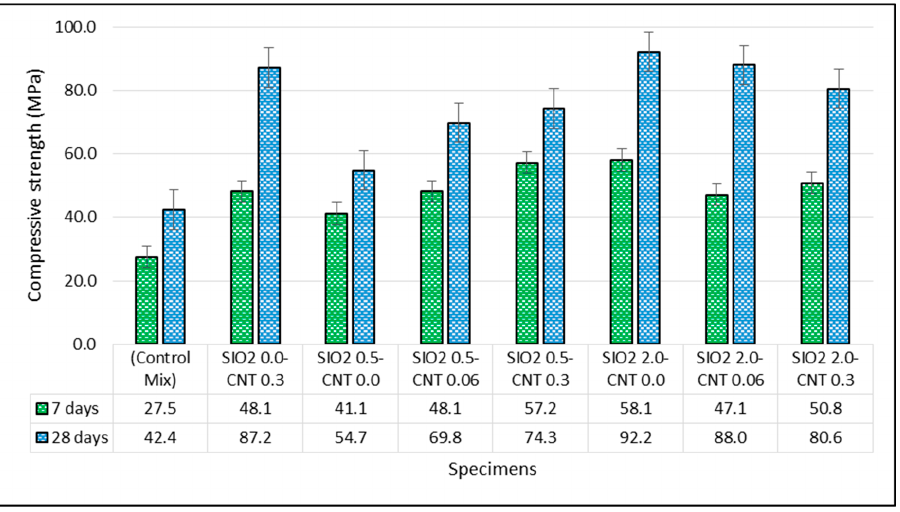
Figure 3. Compressive strength of cement paste specimens at the ages of 7 and 28 days.